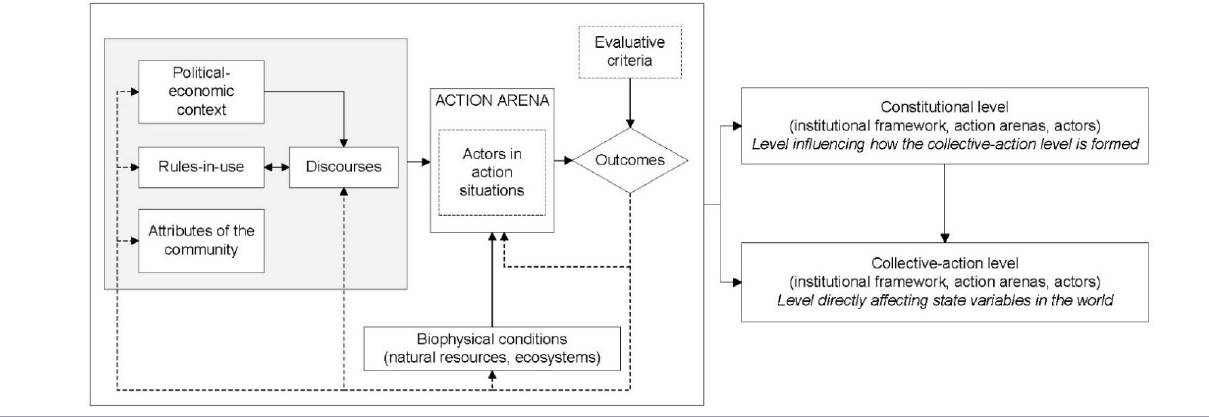
Fig. 3 . The politicized version of the Institutional Analysis and Development framework. Source: modified from Clement (2010) and Clement and Amezaga